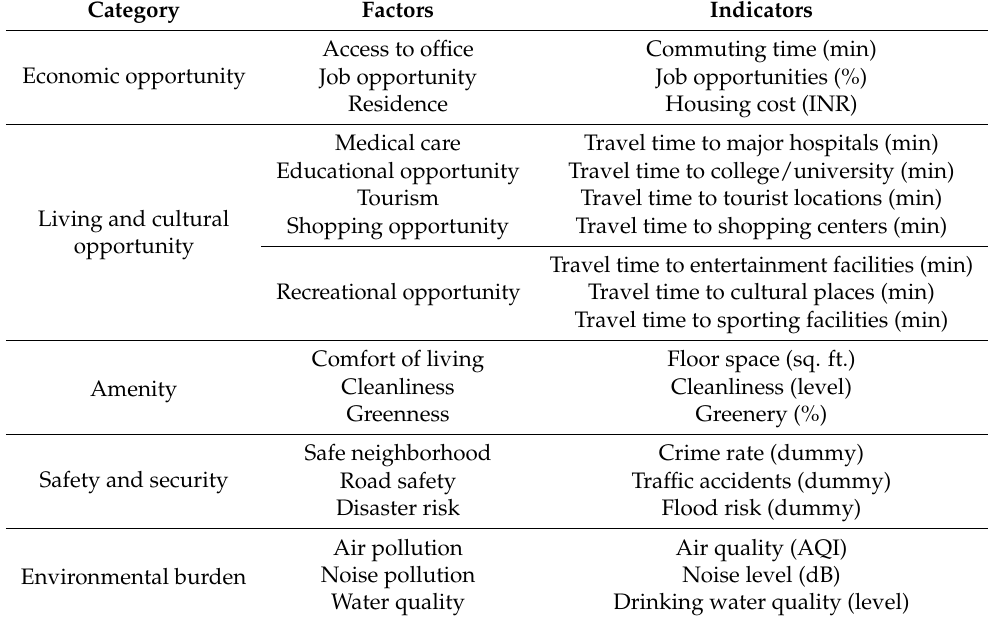
Table 2. Quality of life (QOL) factors.